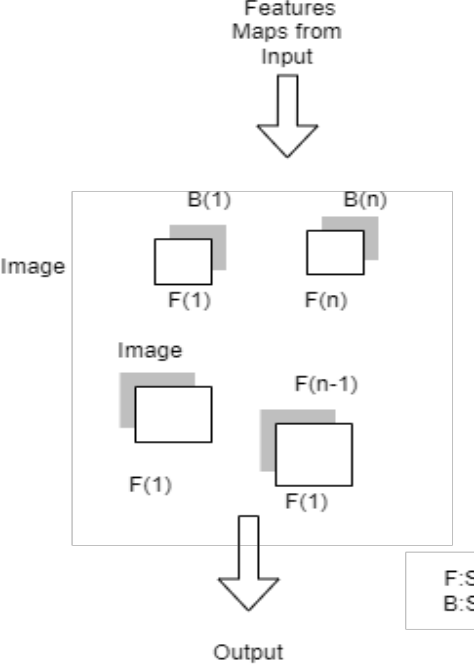
Figure 11. Saliency mechanism.